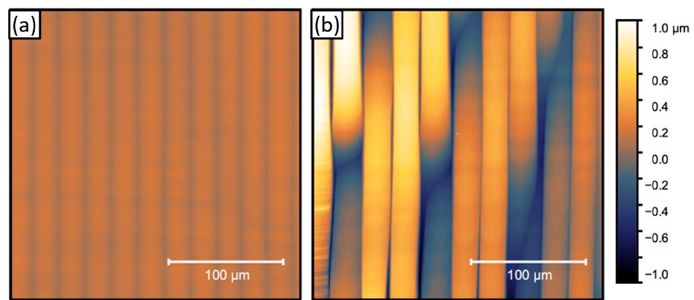
Figure 2. Optical profilometry height maps of solar cell surfaces for the case of ( a ) complete and ( b ) incomplete planarization.